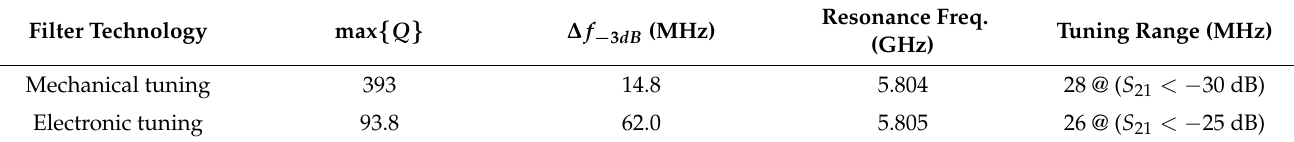
Table 3. Performance summary and benchmark comparison ( ∆ f − 3 dB : bandwidth at half minimal insertion